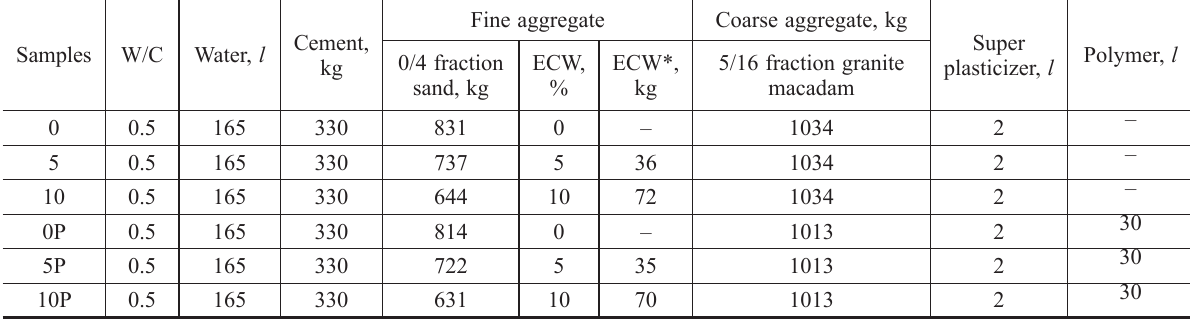
researcha) b) Fig. 2. electrical cable waste particles used in this Table 1. Composition of 1 m 3 of concrete mixtures (concrete mix design was calculated by the absolute Volume Method)